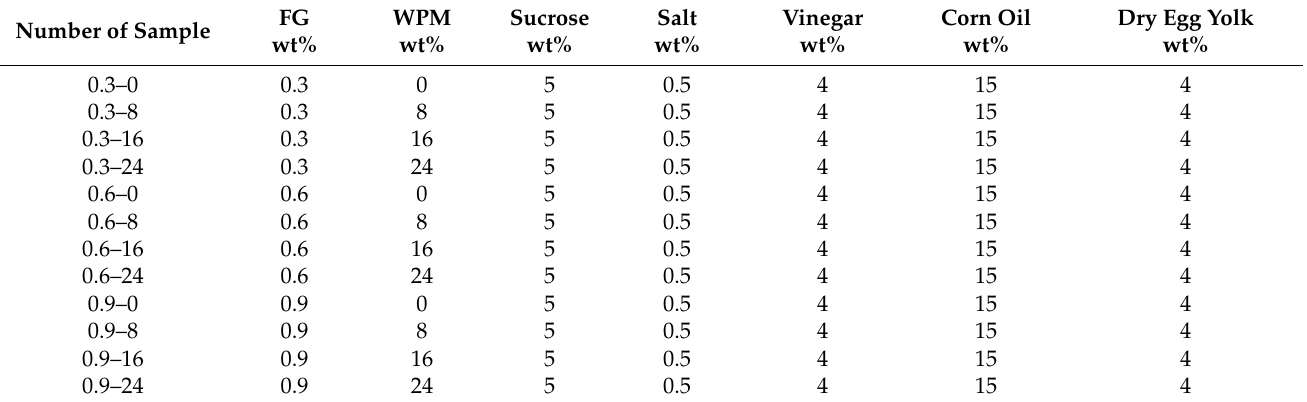
Table 1. Ingredients of model